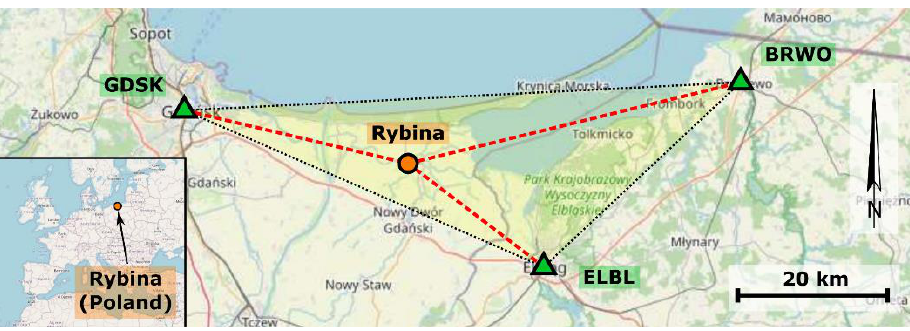
Figure 3. Survey site and adjacent CORS reference stations locations.